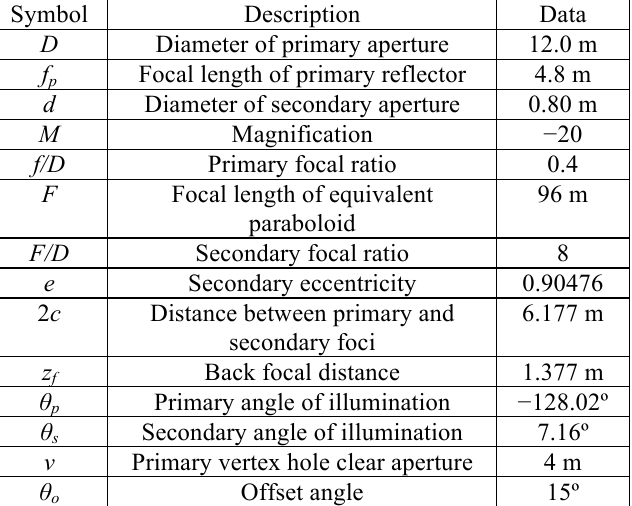
Table 6: Parameters for the off-axis Gregorian antenna. Symbol